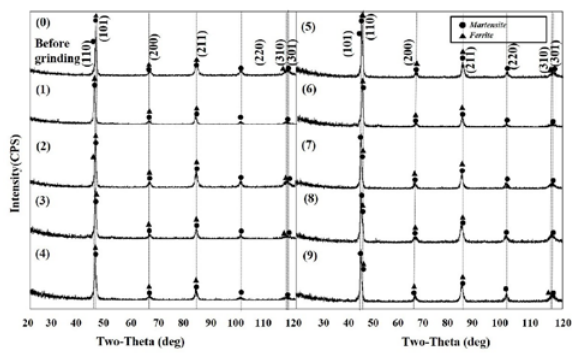
Fig. 3. Phase transformation curve results. The evolution of phase volume fraction (PVF) is vitally important, the phase transformation ratio obtained from the grinding experiment is used to fit the characteristic coefficient of the prediction model. By comparing the prediction results of the model with the experimental results that did not participate in the regression analysis, it is found that the average prediction error of martensite and ferrite is less than 3.5% and 5.5% ， respectively. It can be considered that the prediction model is effectively, and the values of characteristic coefficient m, k and g are as